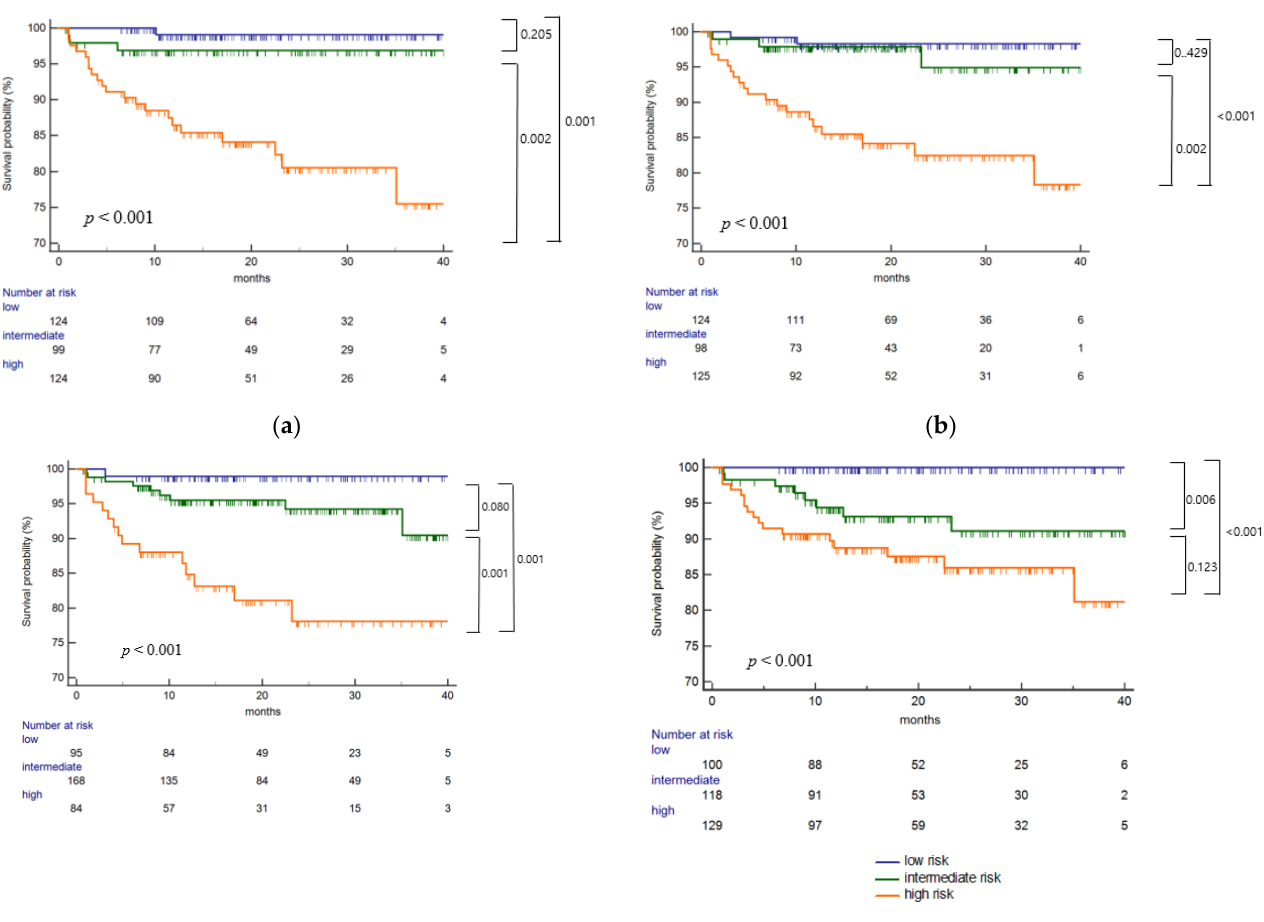
Figure 3. Eplet mismatch analysis on the risk of class II dnDSA development. ( a ) single molecular eplet mismatch, ( b ) total eplet mismatch, ( c ) antibody-verified eplet mismatch and ( d ) antibody- verified single molecular eplet mismatch was significantly associated with the risk of class II dnDSA development ( p < 0.001, p < 0.001, p < 0.001, p < 0.001, respectively). For single molecular eplet mismatch, the high-risk group (HLA-DQ ≥ 10) showed significantly increased risk of dnDSA develop- ment compared to the low (HLA-DR ≤ 7 and HLA-DQ ≤ 9) or intermediate-risk group (HLA-DR ≥ 8 and HLA-DQ ≤ 9) ( p = 0.001, p = 0.002, respectively). For total eplet mismatch, a significant differ-